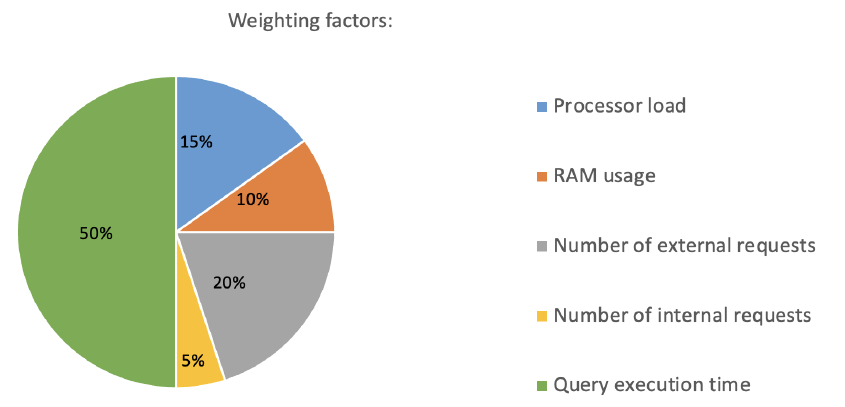
Figure 10. Weighting